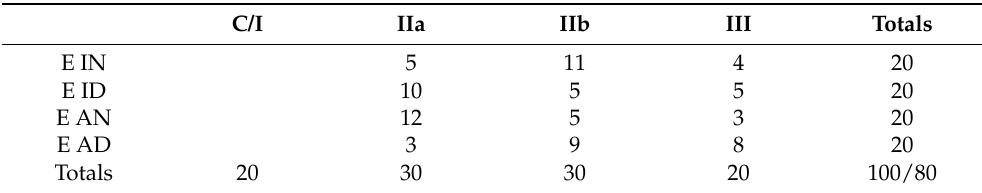
Table 3. The distribution of samples between the two classification systems of (i) Kenney and Doig and (ii) Hoffmann and